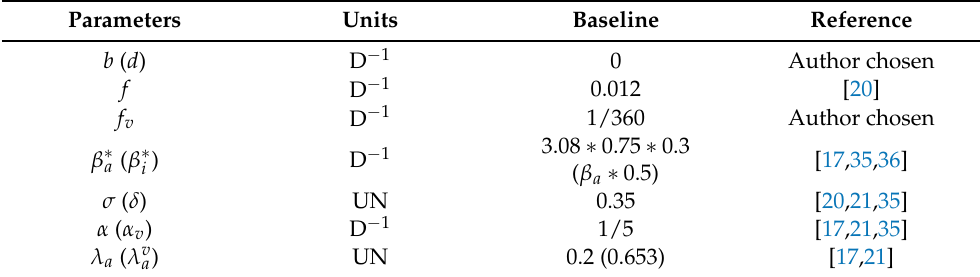
Table A1. Parameter values related to behavior. D = days, UN = unitless. N = N u + N v . In order to not discriminate between people with different beliefs and attitudes towards vaccination, we used the same numeric values for both P ∗ and P ∗ v